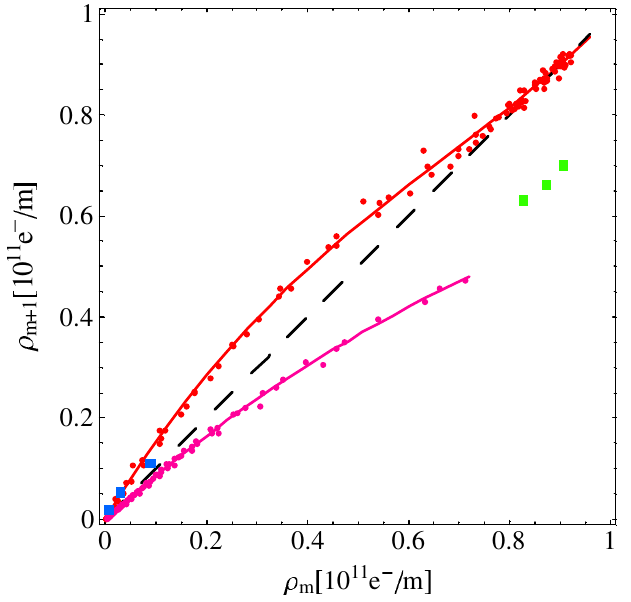
FIG. 4. (Color) Average e-cloud density map (cid:2) circle markers correspond to the ECLOUD computed values for the 24 f (cid:2) 12 e (cid:2) 36 f filling pattern. The lines correspond to the predictions of the map whose parameters have been fitted to the ECLOUD simulation run for the 72 f (LHC reference) filling pattern. In both cases, successive bunch trains are separated by gaps whose length corresponds to 28 (empty) bunches (LHC reference). All other parameters have the values in Fig. 1. The square markers correspond to the transitions between charged and empty bunch subtrains. They can also be fitted by cubic maps, characterized by different coefficients.